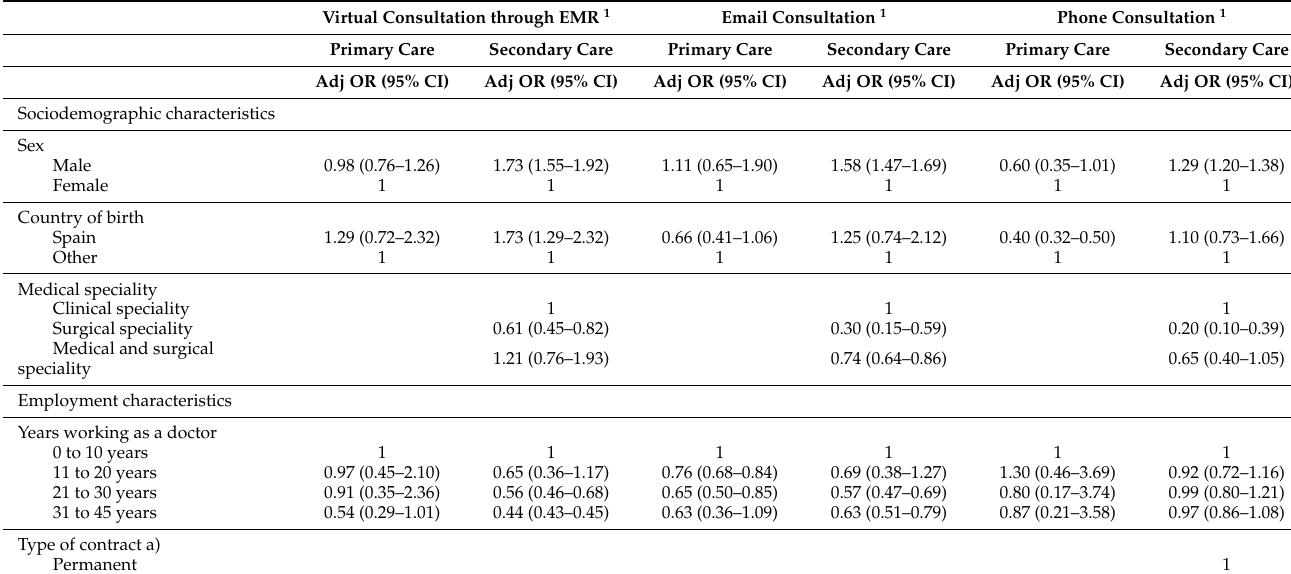
Table 4. Factors associated with the frequent use of virtual consultation through EMR, email and phone consultation, by level of